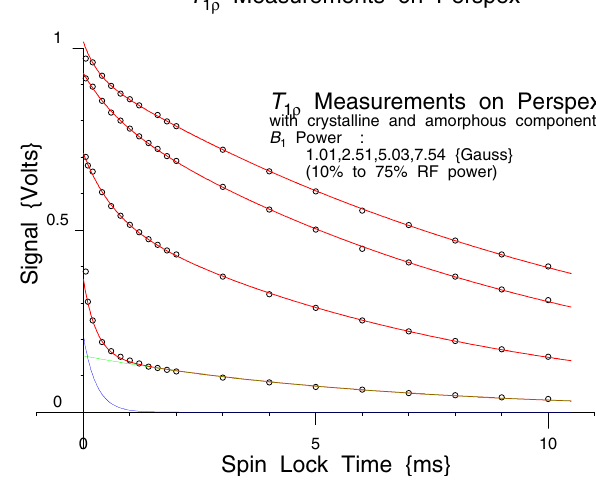
Fig. 11 Showing 2 component T 1 ρ decays at lower spin-lock pow- ers, measured on an Acrylic polymer at room temperature, using a set of spin-locking measurements with RF powers from 1 to 7.5 Gauss. Component ratios are affected by the crystalline/amorphous ratio and the ability of the B 1 pulse to maintain spin-locking in each component. These suggest that the local-field fluctuations in the crystalline component are a bit under 0.6